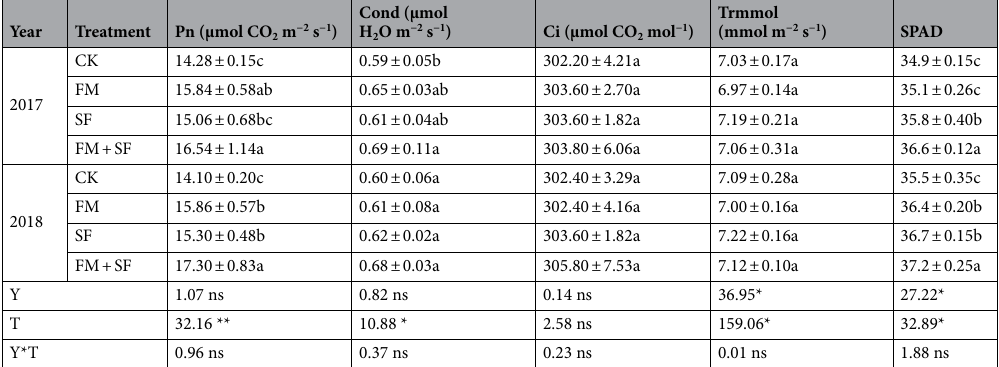
Table 3. Effects of bast fiber film and nano-silicon fertilizer treatments on SPAD and photosynthetic characteristics of rice flag leaves at mid-filling stage. Different letters indicate significant difference at 5% level. Summary of ANOVA results: not significant (ns), significant at p < 0.05 (*), very significant at p < 0.01 (**). Y Year, T Treatment, Pn Net photosynthetic rate, Cond Stomatal conductance, Ci Intercellular carbon dioxide concentration. Trmmol Transpiration